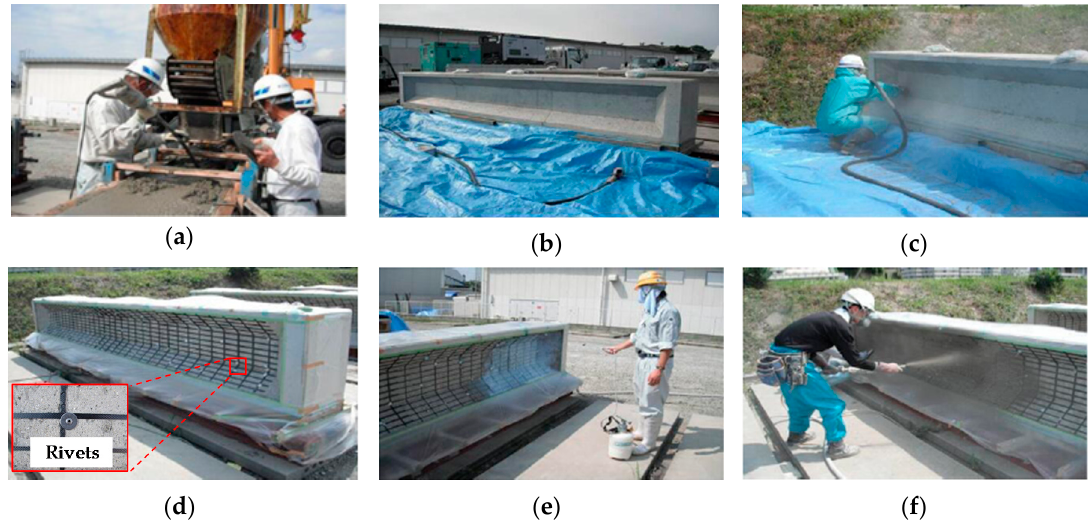
Figure 3. The manufacture process of specimens: ( a ) Concrete cast; ( b ) Original concrete beam; ( c ) Vacuum blast; ( d ) CFRP grid installation; ( e ) Primer mortar spray; ( f ) PCM shotcrete. Grade HRB 335 steel bars with a diameter of 10 mm and spaced at an interval of 250 mm were used as stirrups, where the calculated stirrup reinforcement ratio was 0.38%. The compressive and tensile steel bars of Grade HRB 335 with a diameter of 32 mm were placed in the upper and bottom region to resist the compressive and tensile force, respectively. The tensile steel reinforcement ratio